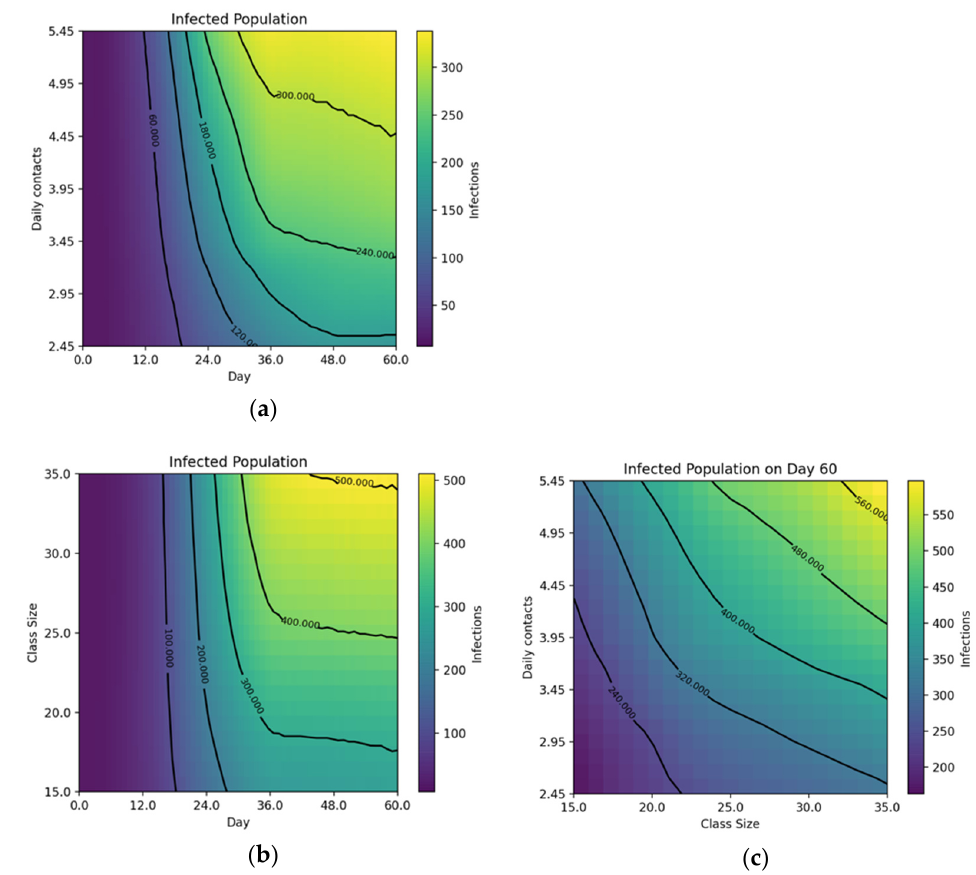
Figure 7. Infection count heatmaps of a range of parameter values. ( a ) Number of contacts per day is varied between 2.45 and 5.45, and the overall infection count is shown vs. time in days. ( b ) Class size is varied between 15 and 35, and the overall infection count is shown vs. time in days. ( c ) Number of contacts per day class size are varied, and the overall total infected count on day 60 is displayed. Contour lines show regions with equal values.